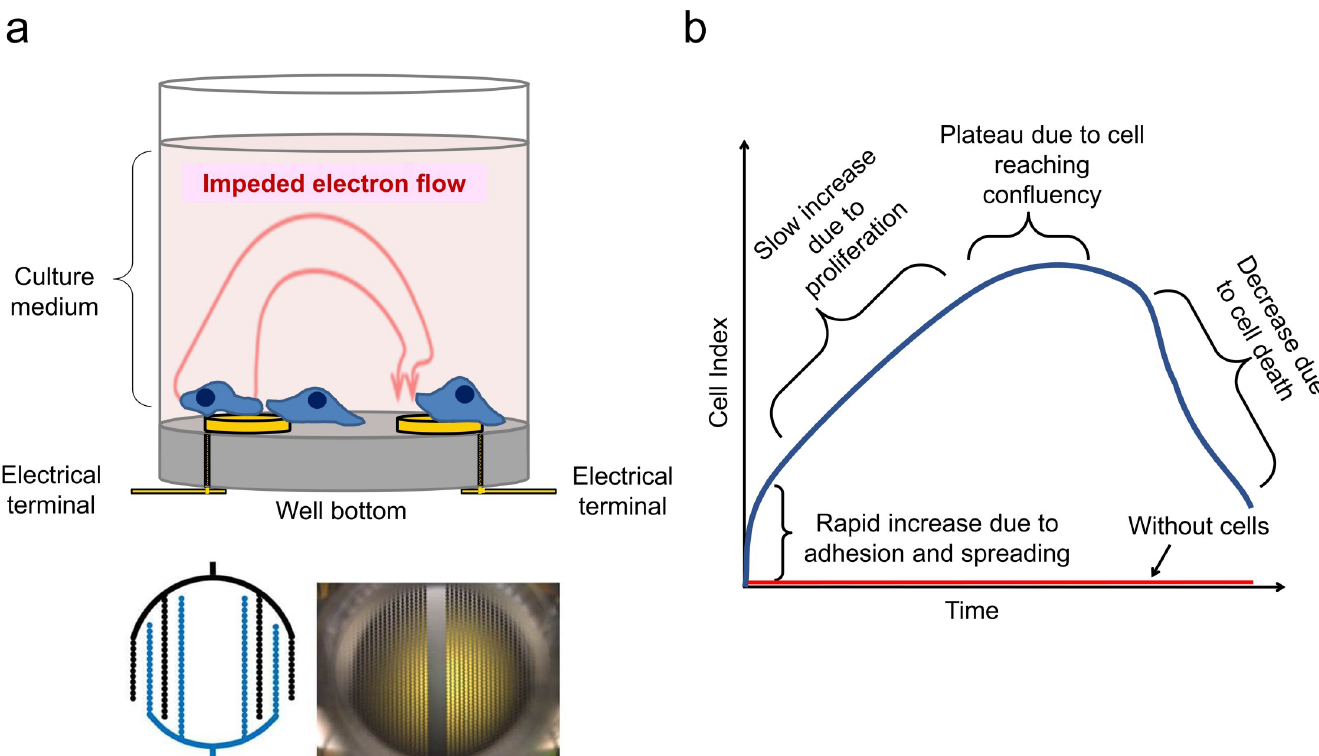
Fig 1. Overview of the xCELLigence impedance-based technology. (A) Multi-well plates have gold electrodes embedded on the bottom that measure the conductivity of the medium through a small current. Adherent cells cover the surface of the electrodes and impede the flow of the current. (B) Typical cell proliferation curve measured through the standardized impedance parameter (Cell Index) shows the different phases of initial cell adhesion, exponential growth, confluency and cell death. The Cell Index without cells is 0. This is based on [20].